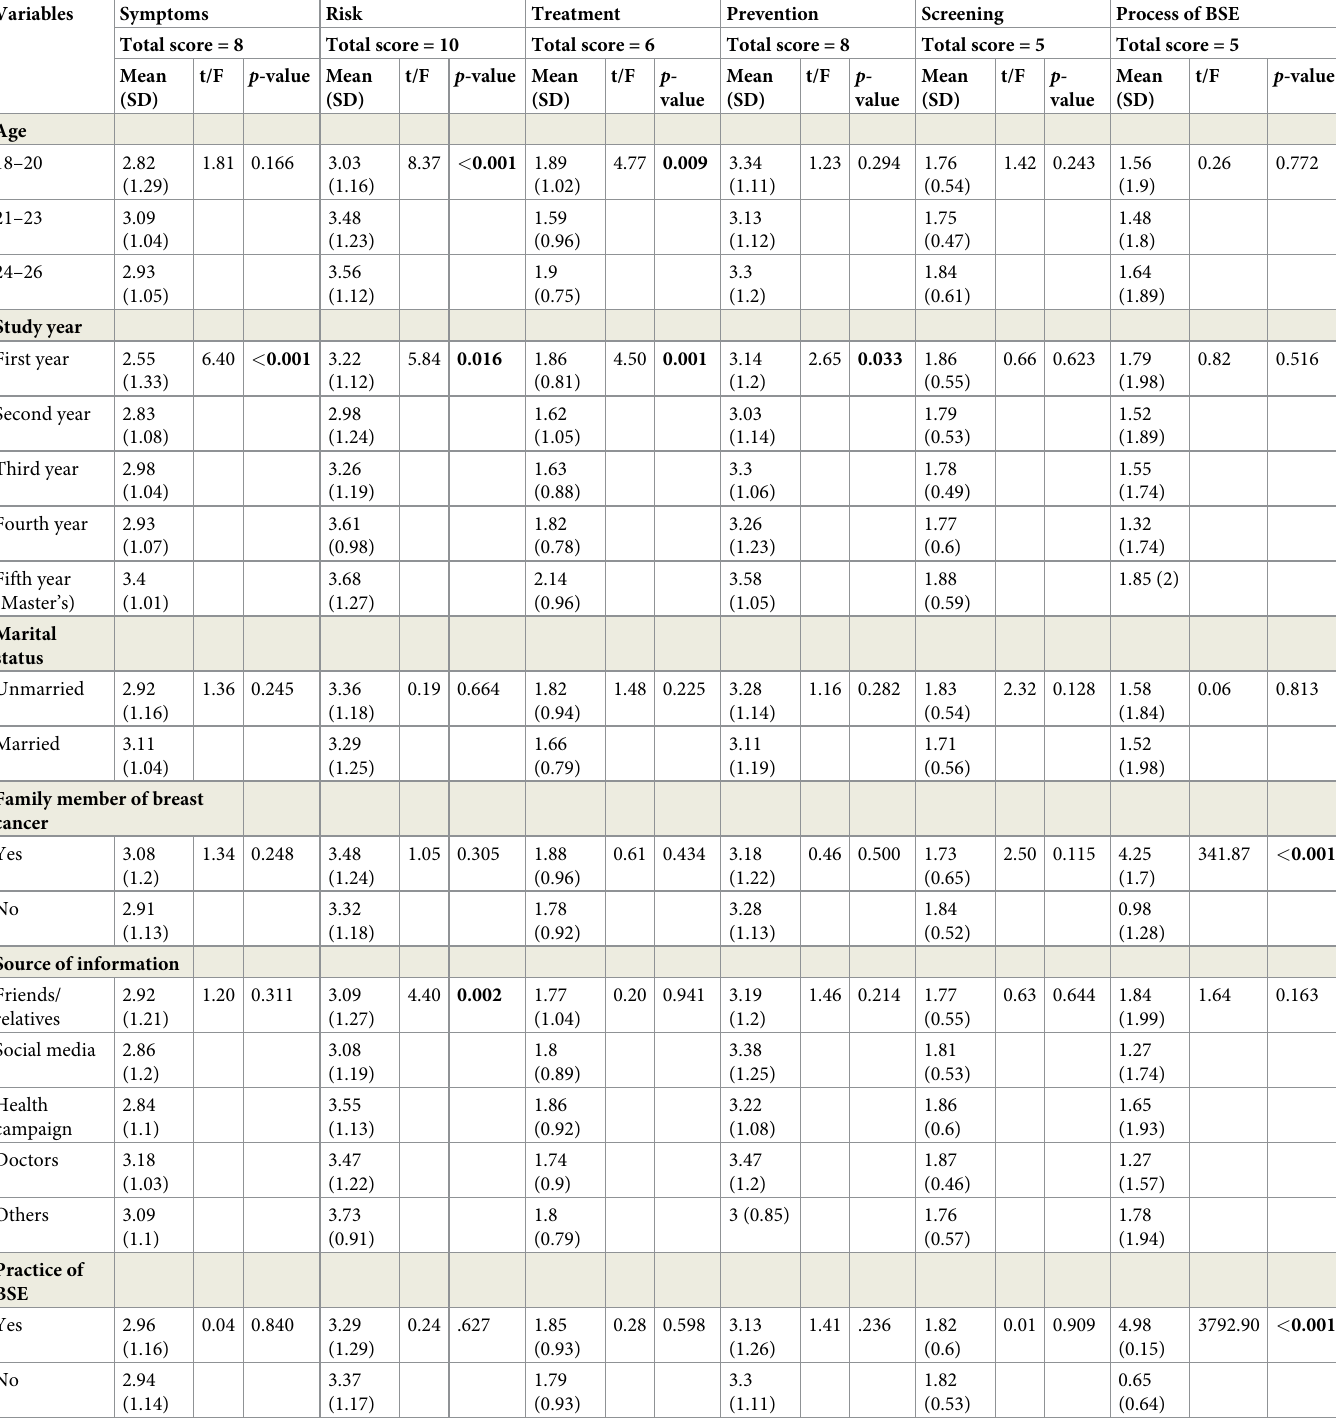
Table 2. Distribution of participants’ knowledge about breast cancer’s symptoms, risk, treatment, prevention, screening, and process of breast self-examination.